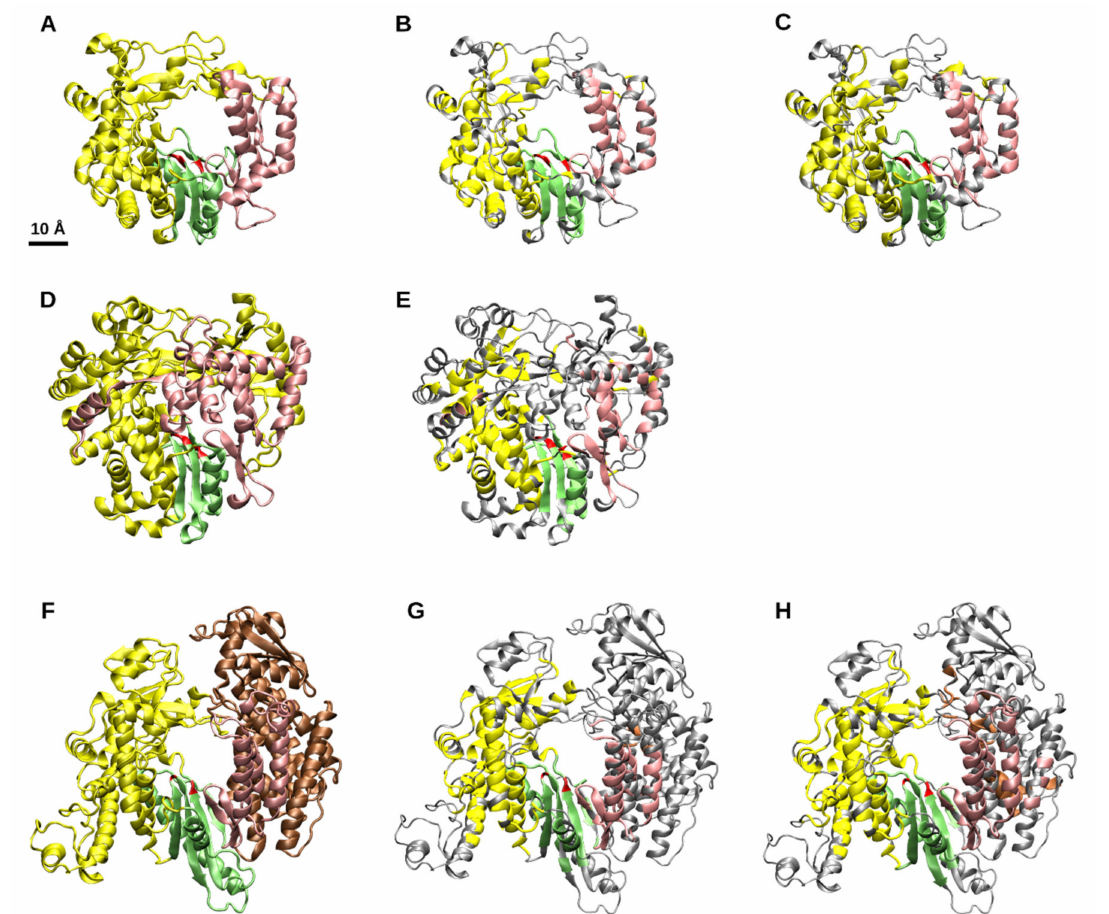
Figure 1. Polymerase subdomains and the common structural core of viral RNA-dependent RNA polymerases (RdRps) depicted on a (+)RNA virus (poliovirus, i.e., enterovirus C ; A – C ), a dsRNA virus (phage phi6; D , E ) and a ( − )RNA virus (vesicular stomatitis Indian virus; F - H ) RdRps [Protein Data Bank identification codes: 3OL6, chain A; 1UVJ, chain A; 5A22 chain A (residues 35-865), respectively]. ( A , D , F ) The polymerase subdomains are indicated as yellow, fingers; green, palm; pink, thumb. Brown color is used for the N-terminal region of the vesicular stomatitis virus [26]. Red residues in the palm subdomain mark the conserved aspartic acid residues. ( B , E , G ) The 231 equivalent residues of the common structural core depicted using the same color code. Residues outside the core are in gray. ( C , H ) Common structural subcores of 323 and 271 residues for the two main RdRp clusters, Cluster I [panel H; comprises reovirus and ( − )RNA virus RdRps] and Cluster II (panel C; comprises rest of the RdRps),